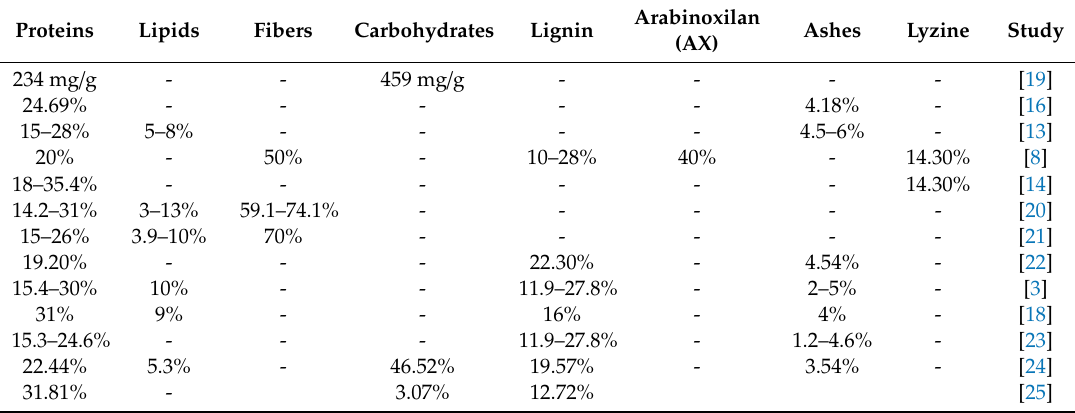
Table 1. Chemical composition of dry brewers spent grain